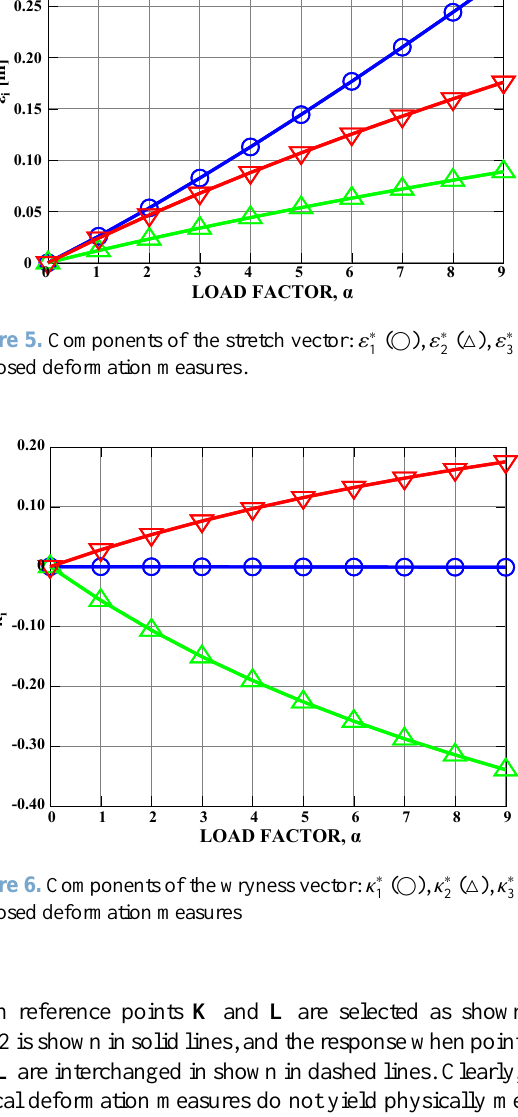
Figure 4. Components of the wryness vector: κ ∗ Typical deformation measures. Reference point K : solid line, point L : dashed line.